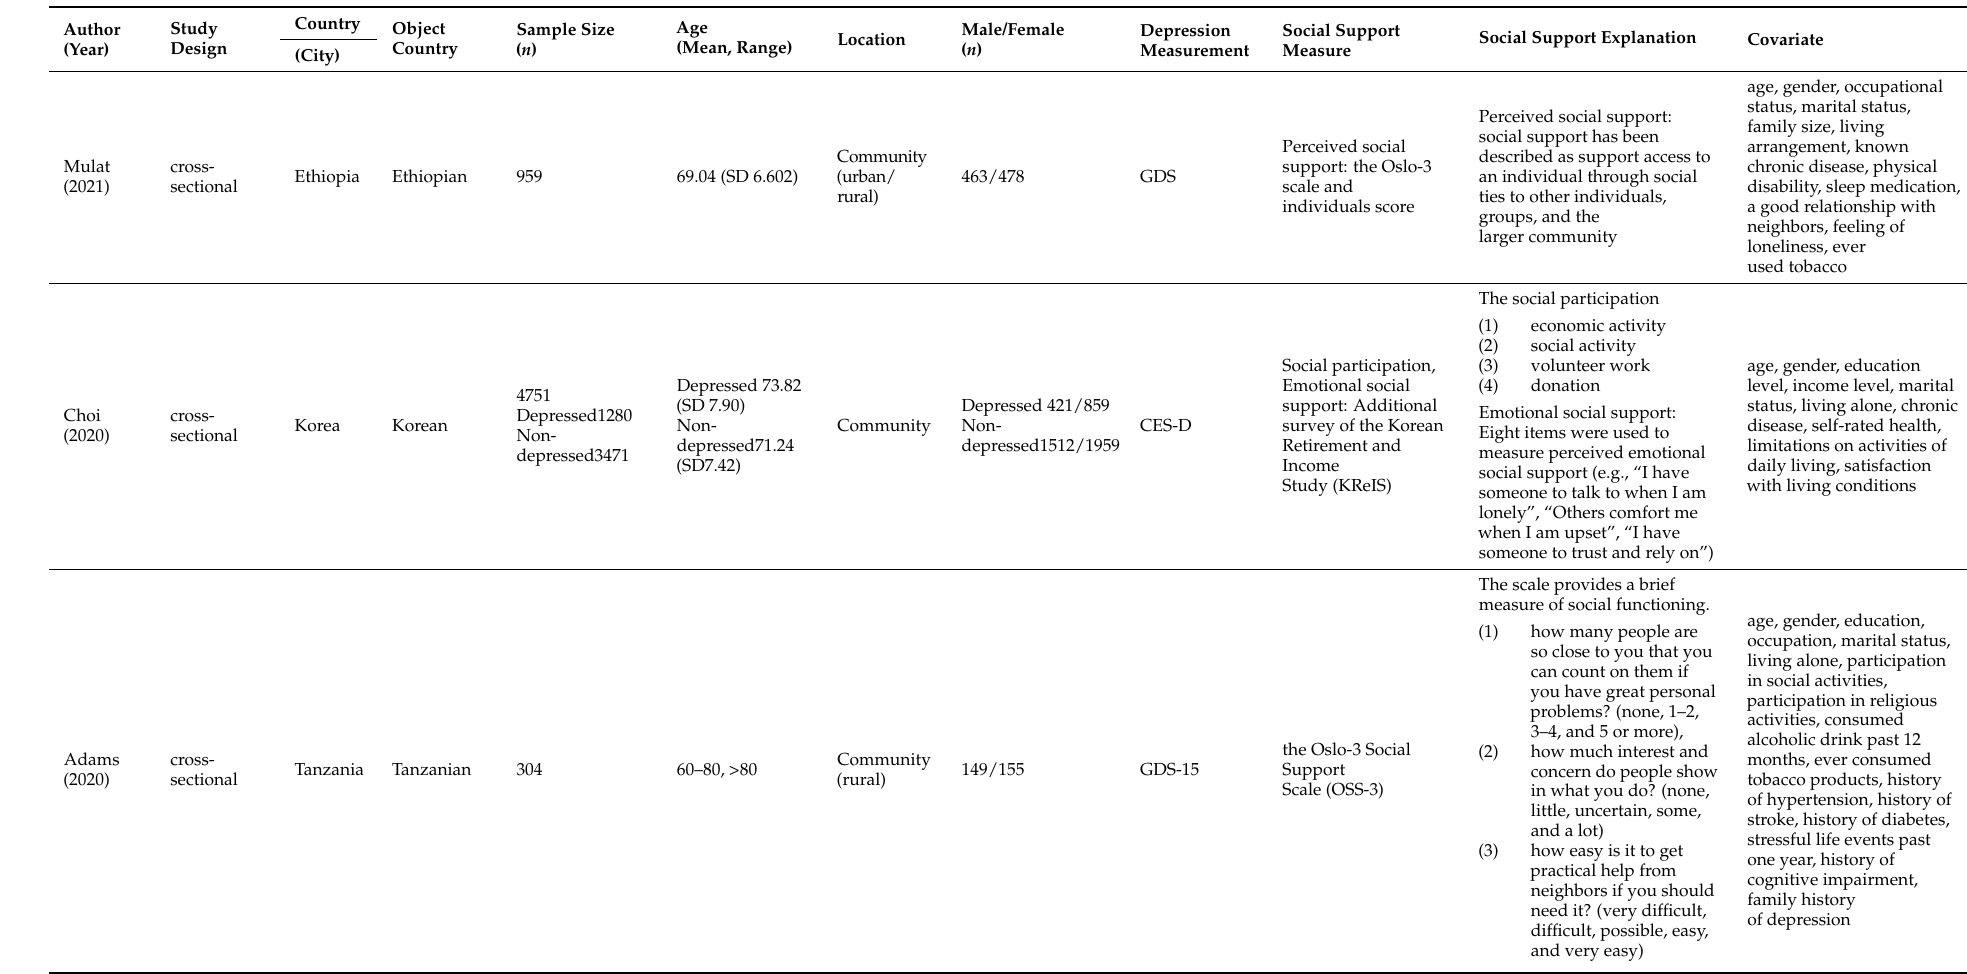
Table 1. The characteristics of the selected studies